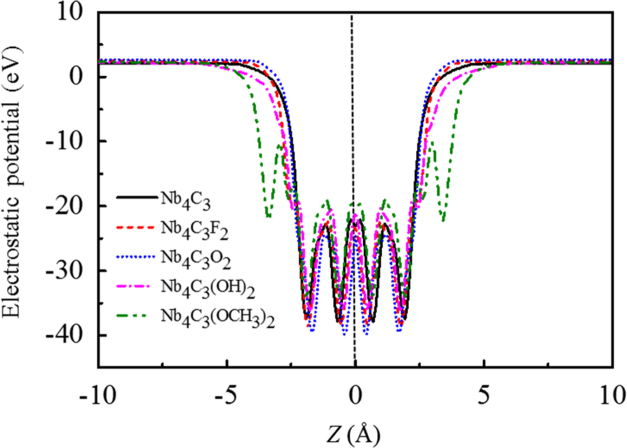
Planar averaged electrostatic potentials along the Z direction of Nb4C3 and Nb4C3Z2 (Z = F, O, OH, OCH3). The peaks in green circles are enlarged to be more clearly.